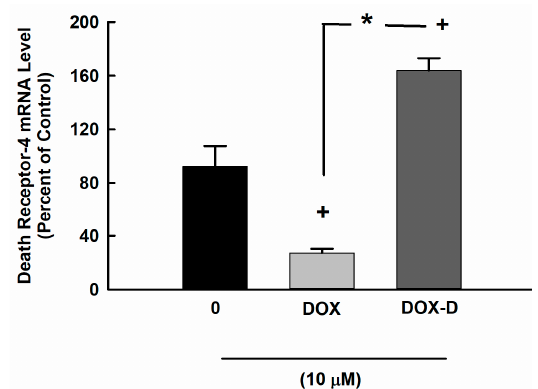
Figure 5. Effect of DOX and DOX-Vit D on the expression of DR-4. MG63 cells were treated for 24 h with 10 µM DOX and DOX-Vit D. Thereafter, total RNA was isolated using TRIzol reagent, and the mRNA level of DR-4 was quantified using real time-PCR and normalized to a β -actin housekeeping gene. The results are presented as the mean ± SEM ( n = 6). + p < 0.05 compared to control. * p < 0.05 compared to DOX.